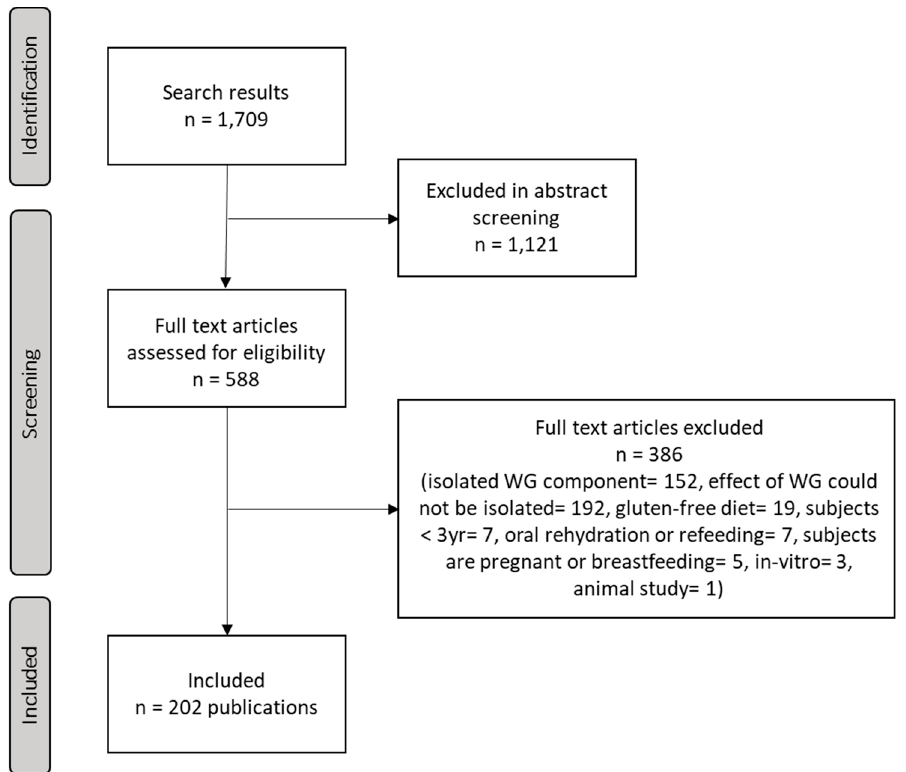
Figure 1. Flow diagram of literature search and screening results.